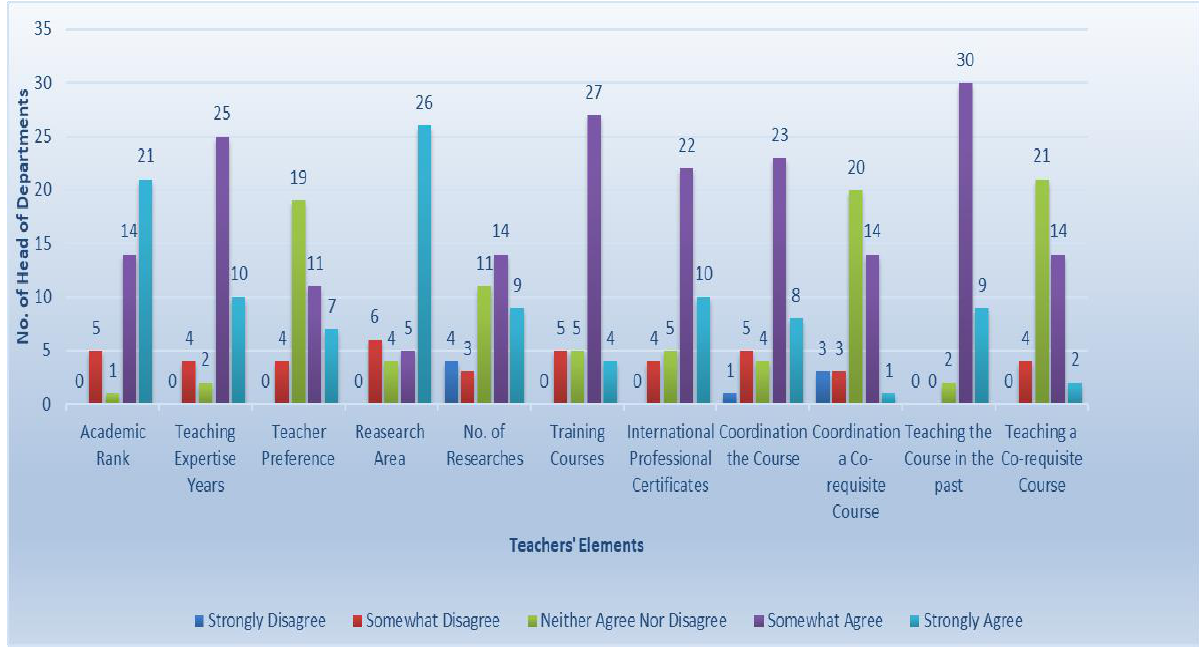
Figure 10. Comparing academic teacher elements.